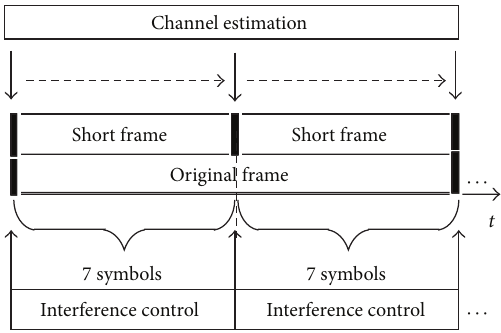
Figure 4: The short frame